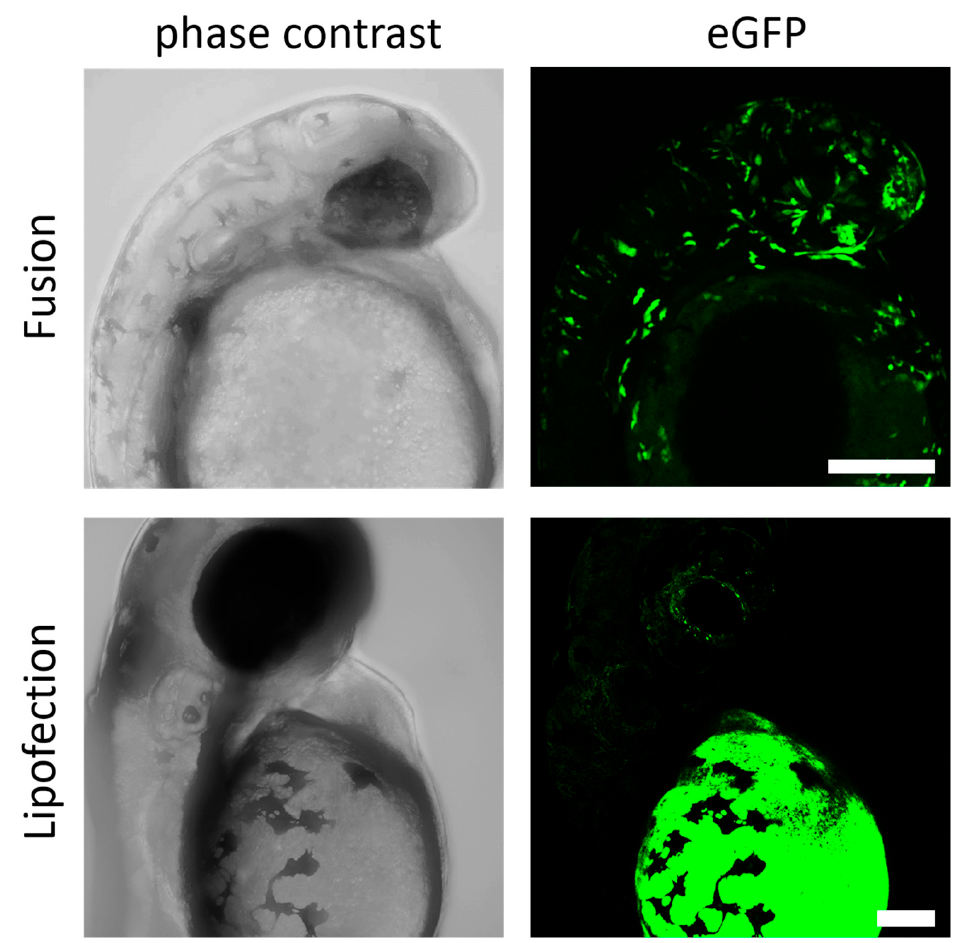
Figure 5. Fusogenic liposomes mediate efficient expression in zebrafish embryos. GFP-mRNA was injected into the zebrafish yolk at 4.5 hpf by endosome-independent (fusion) and endosome-dependent (lipofection) mechanisms. Embryos were analyzed for GFP expression 24 h (fusion) and 48 h (lipofection) after injection. eGFP-mRNA was used in a concentration of 0.3 ng/µL (corresponds to 1.5 ng per injection). Scale bar = 200 µm.